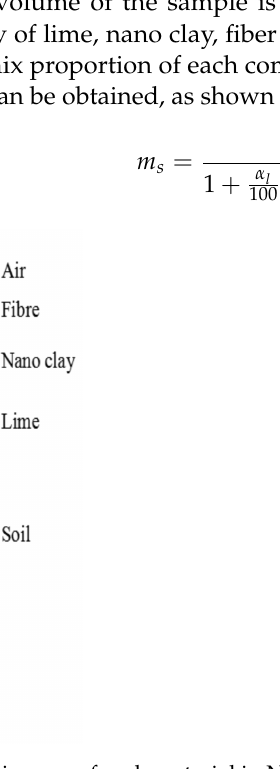
Figure 5. Schematic diagram of each material in